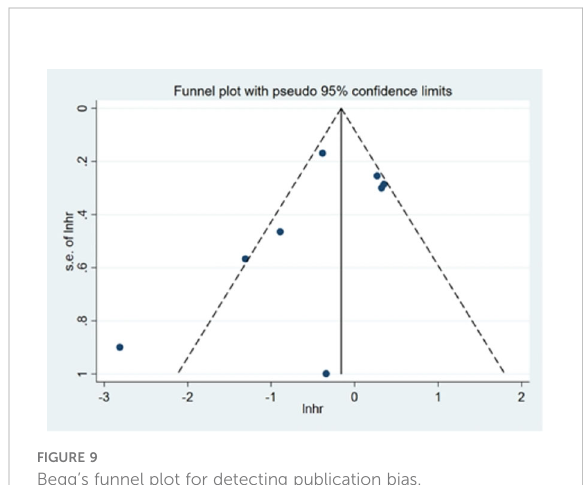
FIGURE 9 Begg ’ s funnel plot for detecting publication